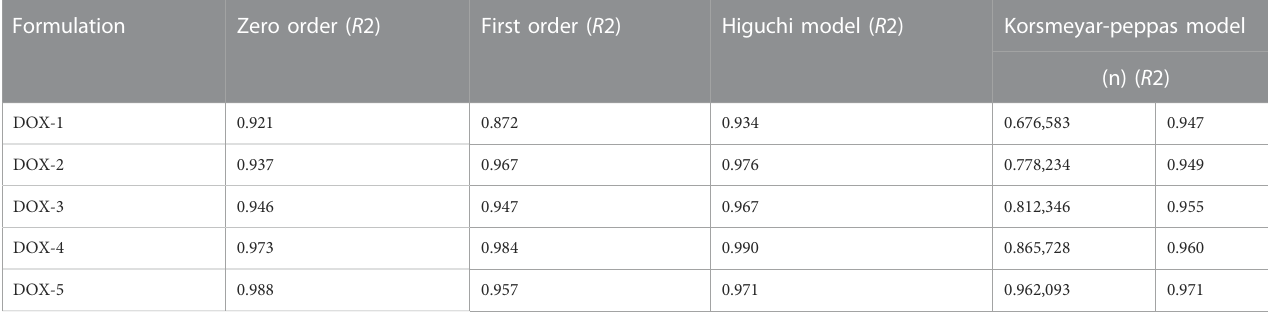
TABLE 3 Pharmacokinetic modelling of the DOX-LPHNS formulations. Formulation